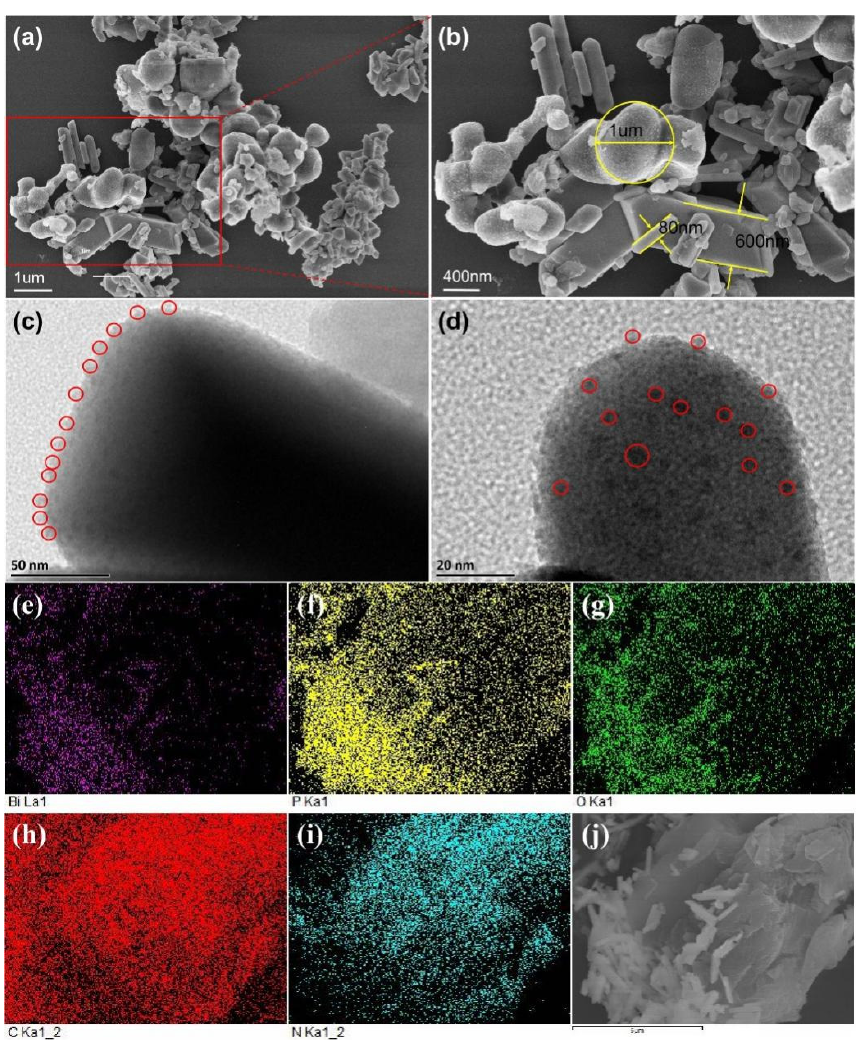
Figure 1. SEM ( a , b,j ) and TEM ( c , d ) images of CDBPC, EDS elemental mapping images of the corresponding area: ( e ) Bi, ( f ) P, ( g ) O, ( h ) C and ( i ) N. Table 1. Elemental composition of CDBPC composite.